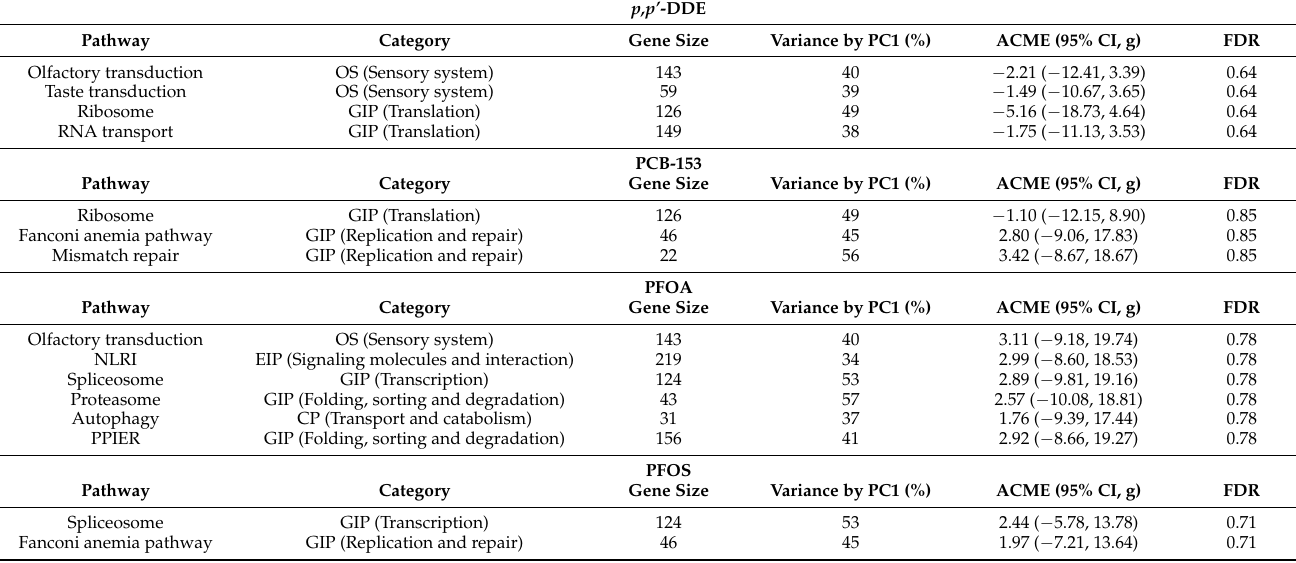
Table 4. The ACMEs of an MDC on birth weight via overlapping